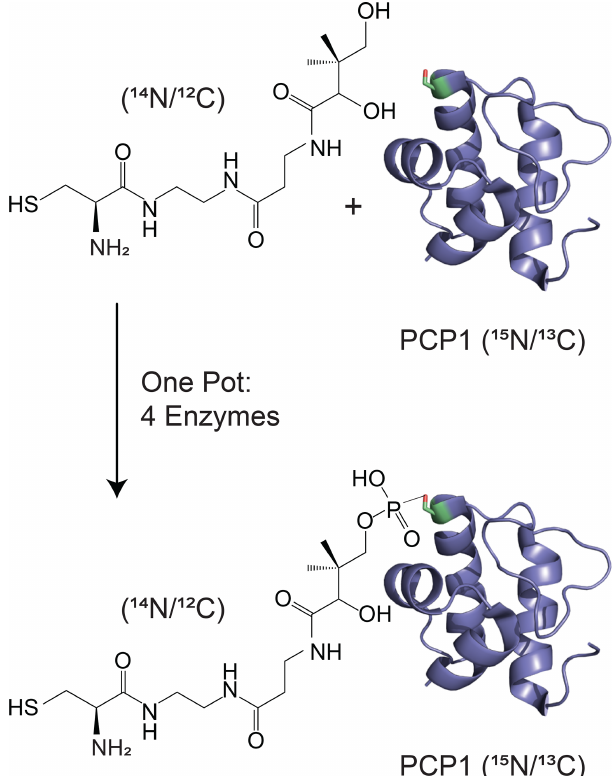
Figure 1. Isotopic labeling scheme used in our studies. Isotopi- cally enriched PCP1 ( 15 N / 13 C) is chemoenzymatically tethered with an unlabeled pantetheine analogue ( 14 N / 12 C) harboring a cys- teine substrate ( 14 N / 12 C). See Sect. 3.2 for more details. PCP1 so- lution structure: PDB 5U3H (Harden and Frueh, 2017). Analogue structures were made in ChemDraw (PerkinElmer